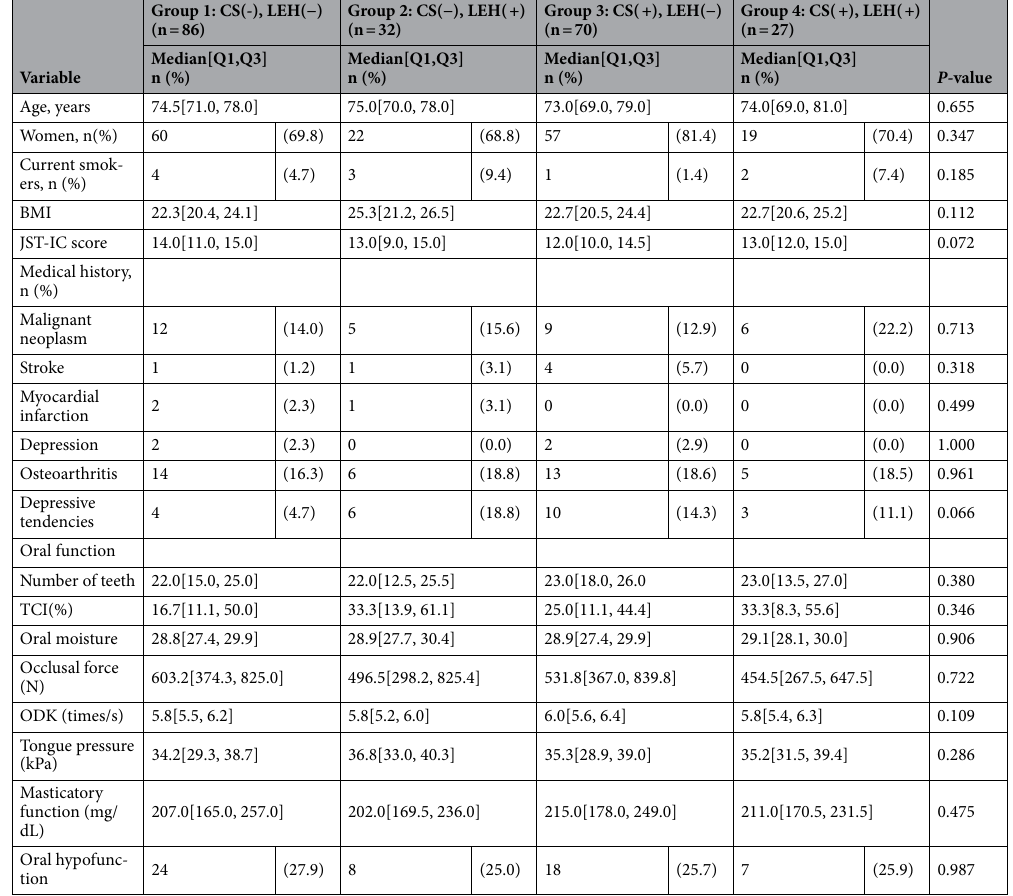
Table 3. Comparisons among the four groups for the risk of poor OHRQoL. Categorical variables are shown as numbers (percentages) and were analyzed by performing either the chi-square test or Fisher’s exact test. Continuous variables are expressed as median [Q1, Q3], and were analyzed using the Kruskal–Wallis test. P-values < 0.05 were considered statistically significant. Abbreviations: BMI, body mass index; CS, COVID- 19-related stress; JST-IC, Japan Science and Technology Agency Index of Competence; LEH, lack of exercise habits; ODK, oral diadochokinesis; OHRQoL, oral health-related quality of life; Q1, first quartile; Q3, third quartile; TCI, tongue coating index.